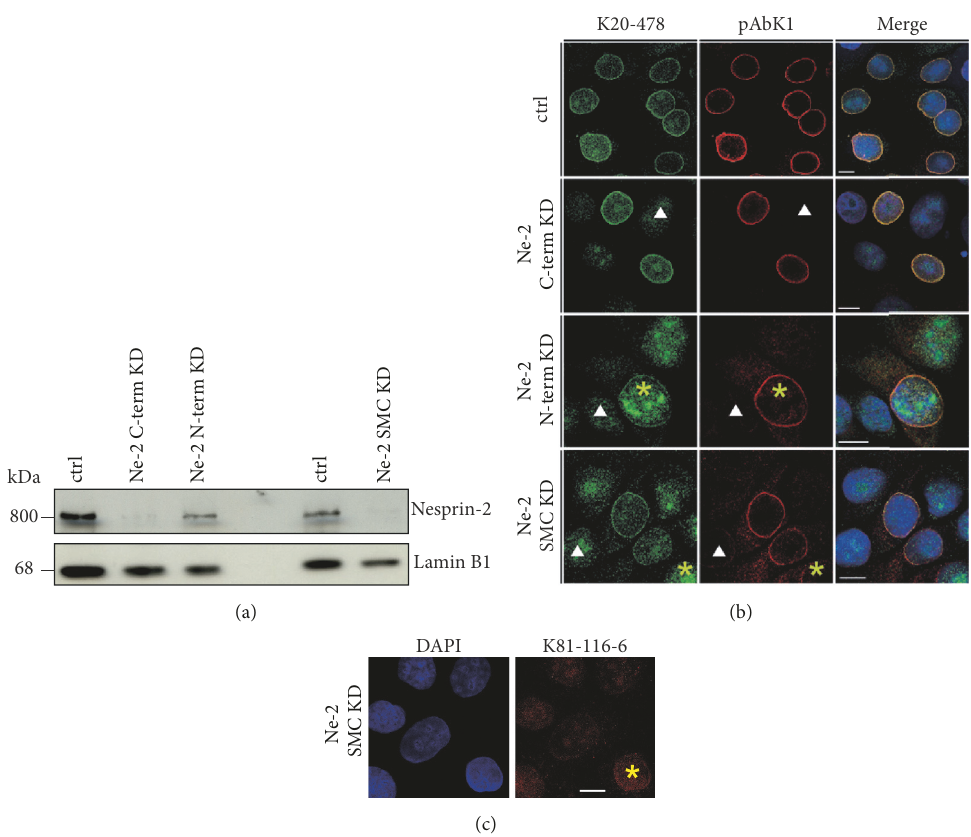
Figure 4: Knockdown of Nesprin-2 using shRNA directed against C-terminal, N-terminal, and SMC domain sequences. (a) Western blots showing the efficiency of the shRNA treatment at the protein level. HaCaT cells were transfected with shRNAs targeting the various regions and for control (ctrl) with the corresponding scrambled shRNAs. Nesprin-2 at ∼ 800 kDa was detected by mAb K20-478. Lamin B1 was used for loading control. (b) Immunofluorescence analysis of HaCaT cells treated with shRNAs targeting the C-terminus (Ne-2 C-term KD), the N-terminus (Ne-2 N-term KD), or the SMC domain (Ne-2 SMC KD). Cells were stained with antibodies directed against the N-terminus (mAb K20-478, green) and the C-terminus (pAbK1, red) of Nesprin-2. DAPI was used to visualize DNA. Arrowhead indicates cells with successful knockdown; asterisk indicates cells which still express Nesprin-2. Bar, 10 𝜇 m. (c) Immunolabelling of Ne-2 SMC KD cells with mAb K81-116-6. Nuclei were labeled with DAPI. Asterisk indicates a cell which still expresses Nesprin-2. Bar, 10 𝜇